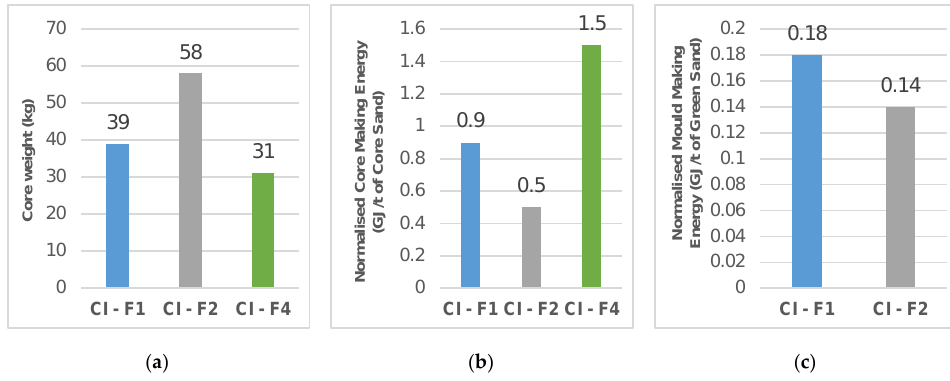
Figure10. Mold-andcore-making: ( a )coreweight, ( b )core-makingenergy, and( c Figure 10: Mold- and core-making: ( a ) core weight, ( b ) core-making energy, and ( c ) mold-making energy.